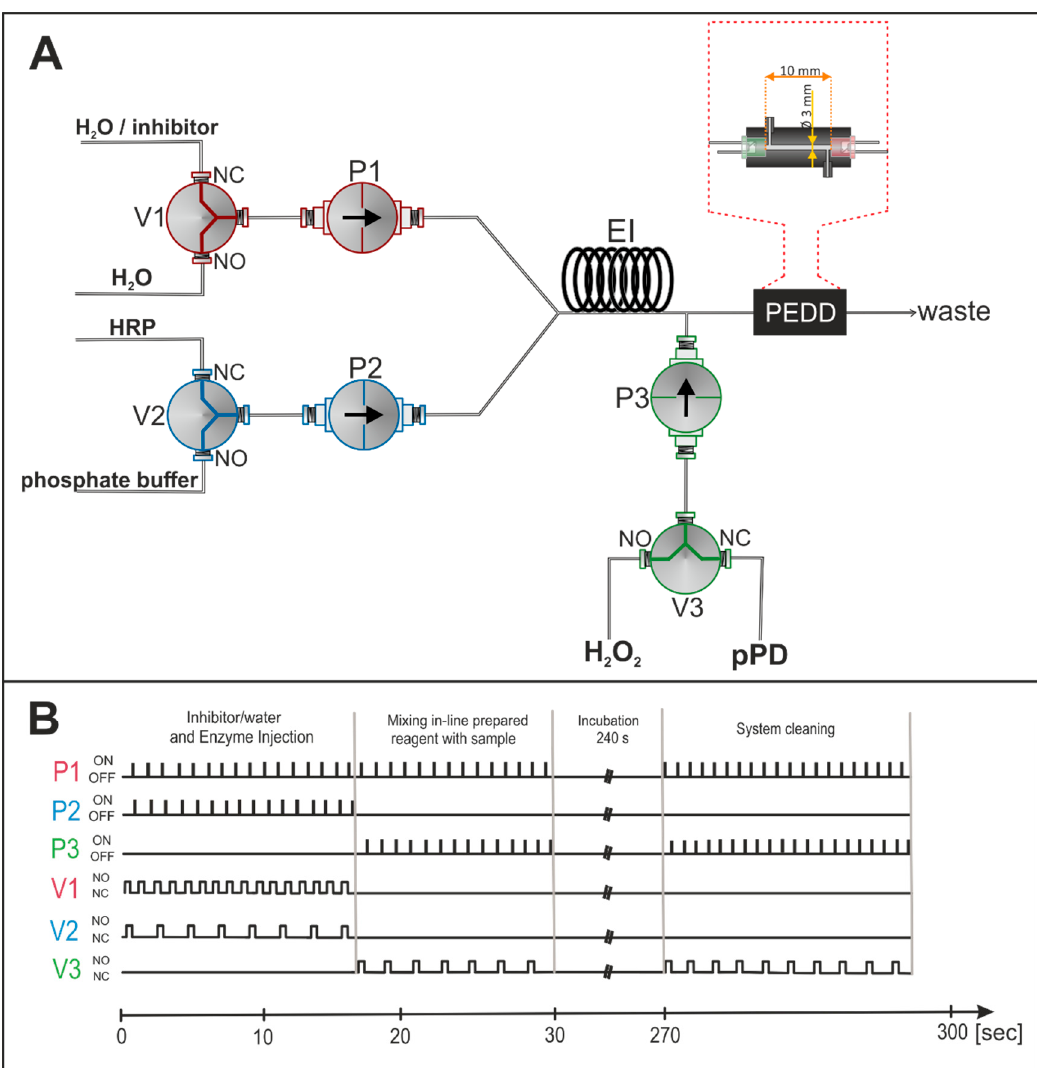
Figure 1. Scheme of multicommutation flow analysis system for the determination of both HRP enzymatic activity and the selected thiol contents ( A ) and the controlling program of the microsolenoid devices ( B ). Abbreviations used in the figure: NO—normally open, NC—normally closed, P—solenoid micropump, V—solenoid microvalve, EI—enzyme-inhibitor mixing coil, PEDD—paired emitter-detector diode.